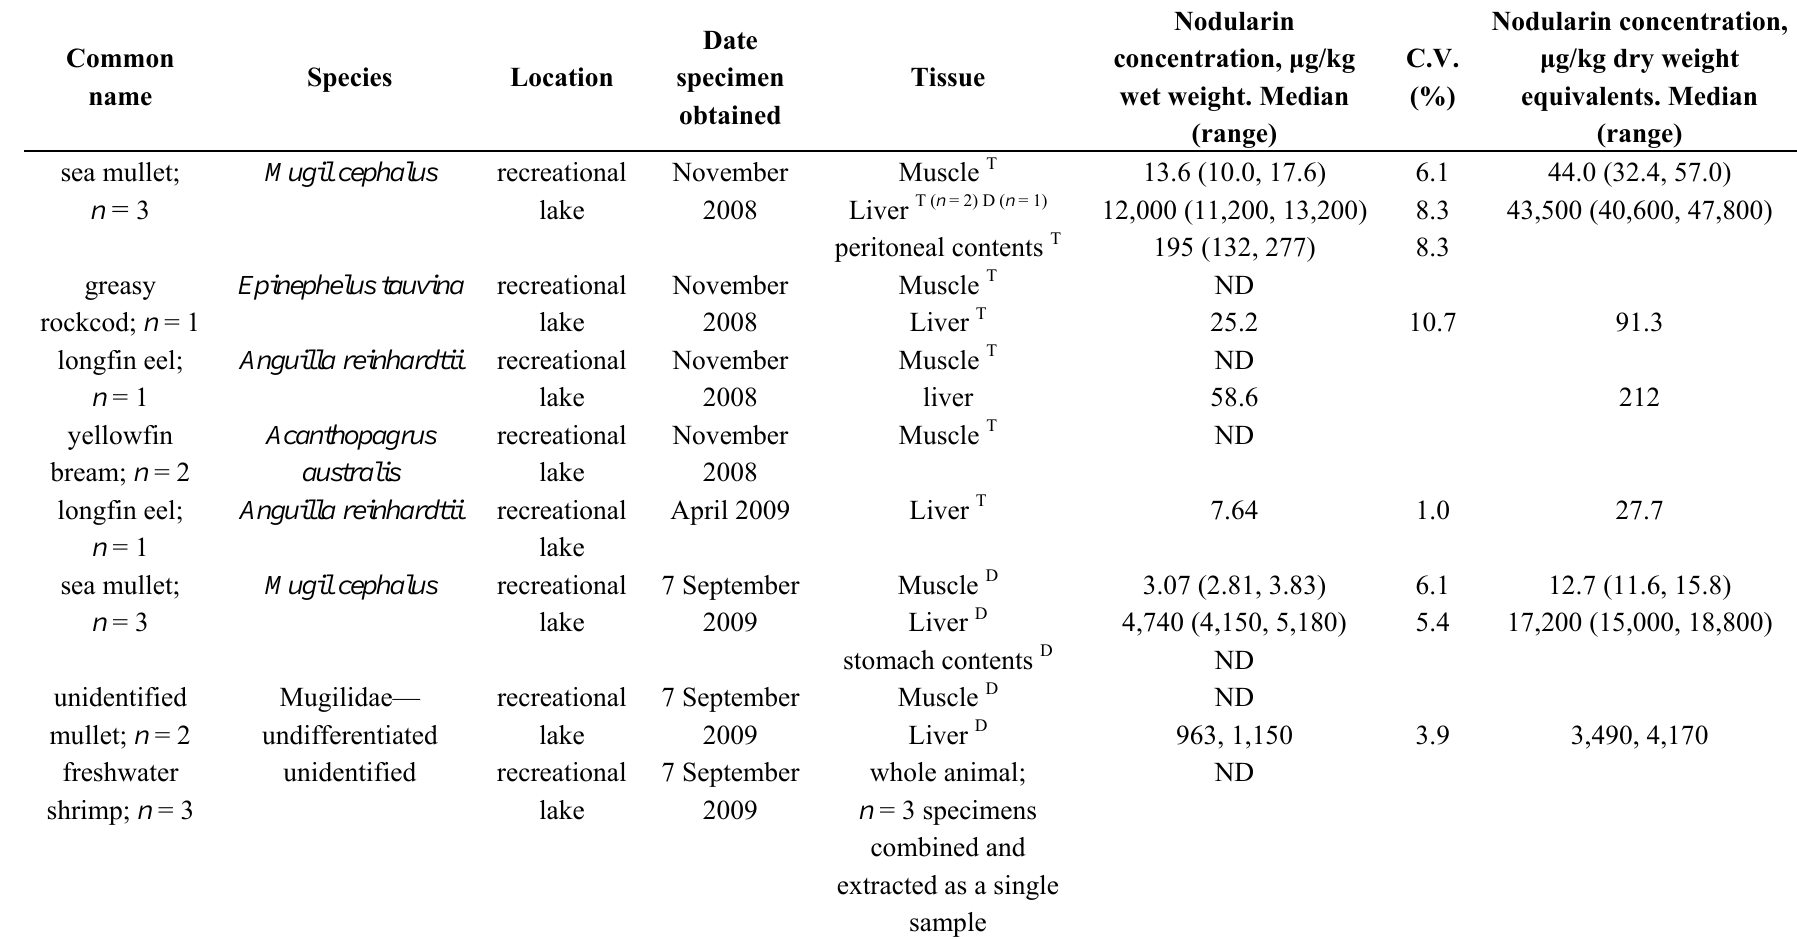
Table 2. Nodularin concentrations in tissues of specimens from the study recreational lake and nearby reference